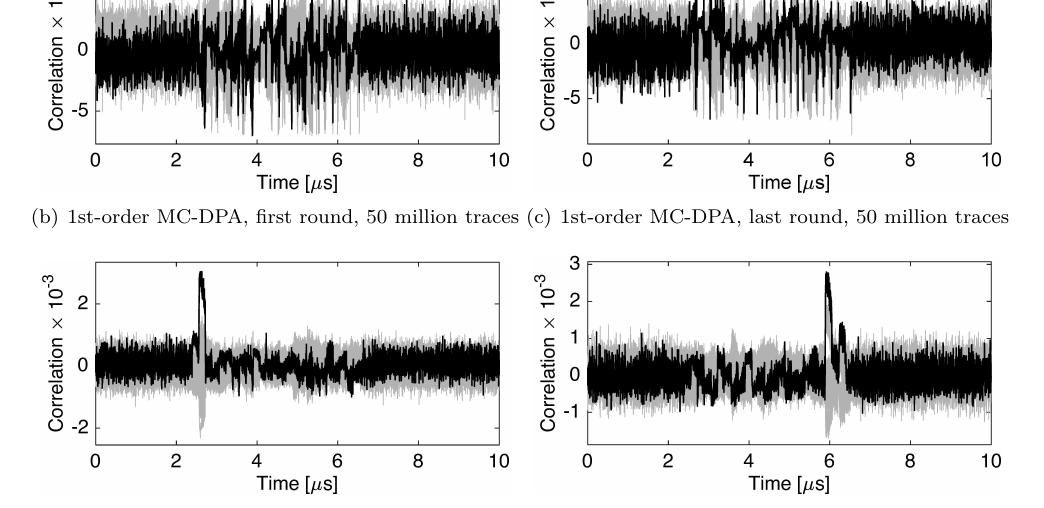
Figure 8: Experimental analysis of our PRINCE encryption/decryption